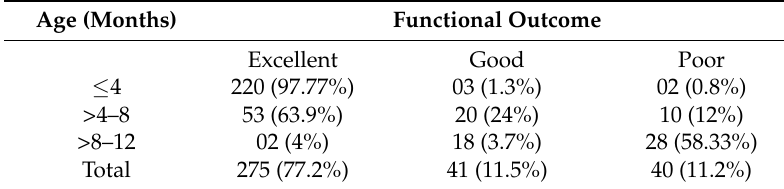
Table 4. Distribution of final outcome.